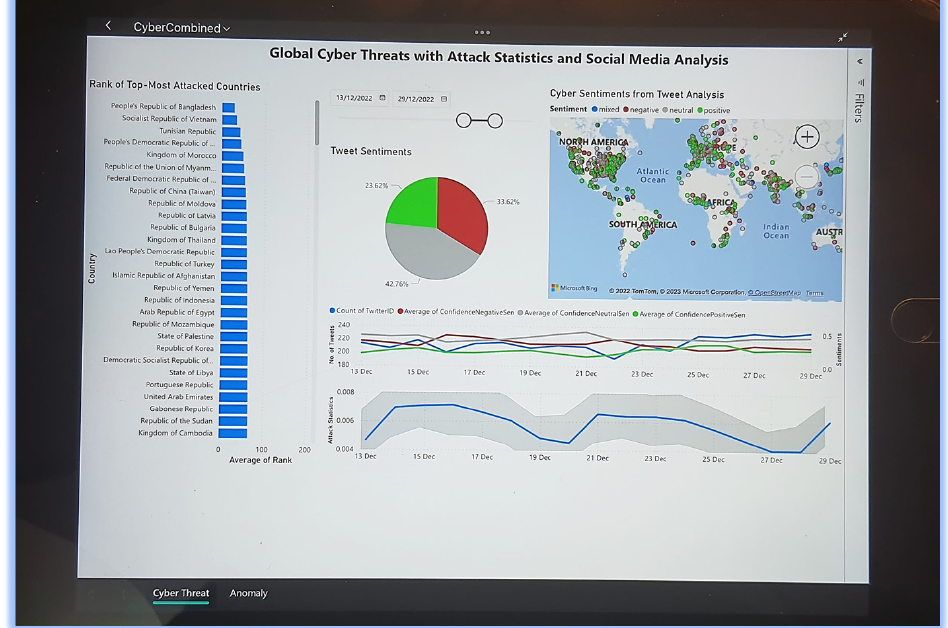
Figure 5. Social media-based cyber threat dashboard executed on an Apple iPad 9th Generation (iOS Device). Table 8. Numbers of anomalies detected with different percentages of sensitivity. Sensitivity of Anomaly Detection